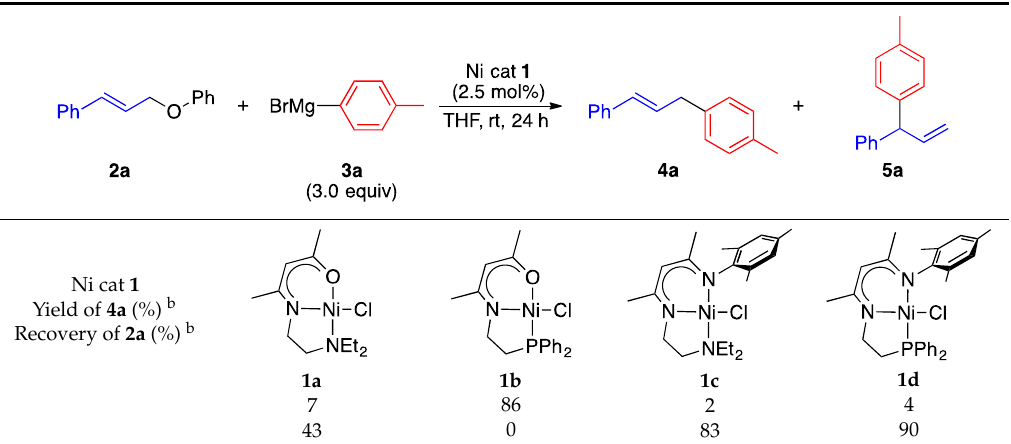
Molecules 2019 , 24 FOR PEER REVIEW Table 1. The cross-coupling reaction of cinnamyl phenyl ether 2a with p -tolylmagnesium bromide 3a Table 1. The cross-coupling reaction of cinnamyl phenyl ether 2a with p -tolylmagnesium bromide 3a Table 1. The cross-coupling reaction of cinnamyl phenyl ether 2a with p -tolylmagnesium bromide 3a Table 1. The cross-coupling reaction of cinnamyl phenyl ether 2a with p -tolylmagnesium bromide 3a Table 1. The cross-coupling reaction of cinnamyl phenyl ether 2a with p -tolylmagnesium bromide 3a Table 1. The cross-coupling reaction of 2a with 3a using Ni(II) pincer complexes ( 1 ). a using Ni(II) pincer complexes ( 1 ). a using Ni(II) pincer complexes ( 1 ). a using Ni(II) pincer complexes ( 1 ). a using Ni(II) pincer complexes ( 1 ). using Ni(II) pincer complexes ( 1 ). a